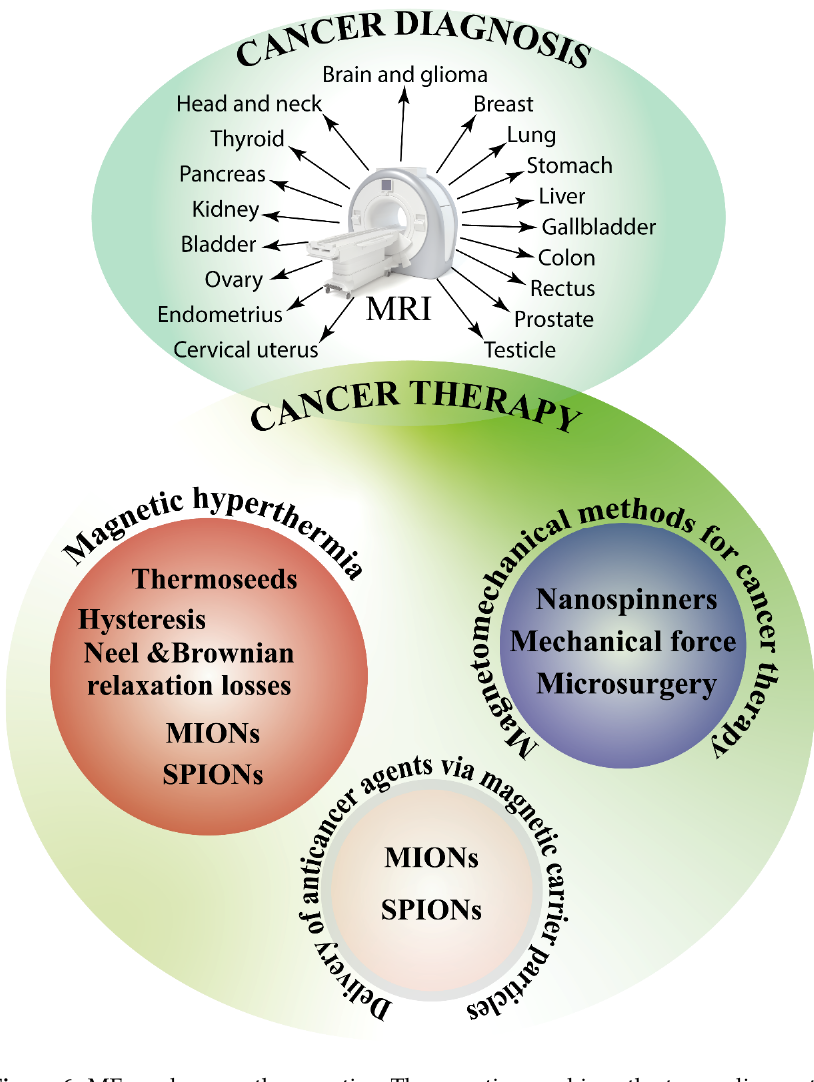
Figure 6. MFs and cancer theranostics. Theranostics combines the terms diagnostics and therapy. MF are used in MRI for the diagnosis of several cancers, whereas the use of magnetic nanoparticles for cancer therapy encompasses three major areas: magnetic hyperthermia that is aimed to kill cancer cells with heat; drug delivery by the use of SPIONs and MIONs; and the exploitation of MNP mechanical forces for application in nano and microsurgery.